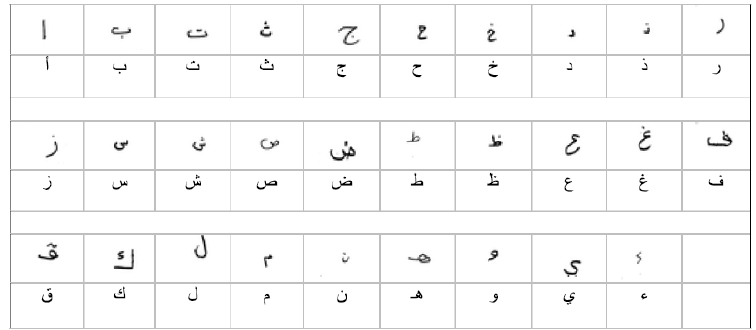
Figure 1. Sample of the Hijja dataset [2].